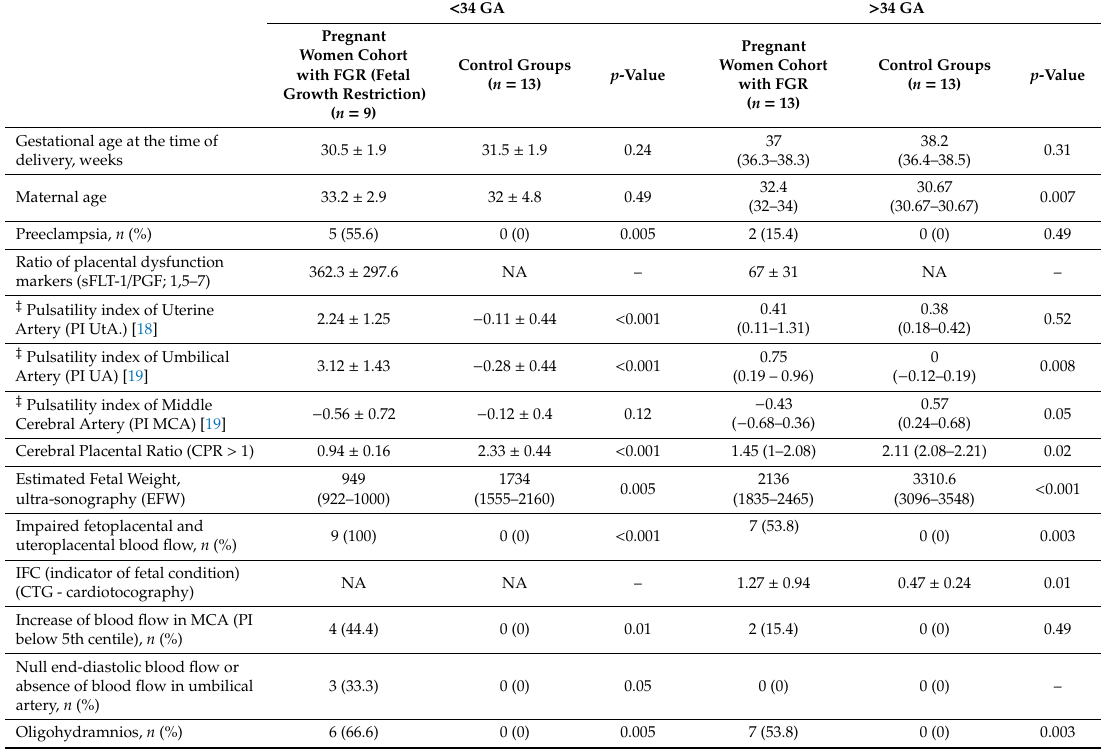
Table 1. Clinical characteristics, ultra-sonography and Doppler sonography of pregnant women. < 34 GA > 34 GA Pregnant Women Cohort Control Groups with FGR (Fetal ( n = Growth Restriction)